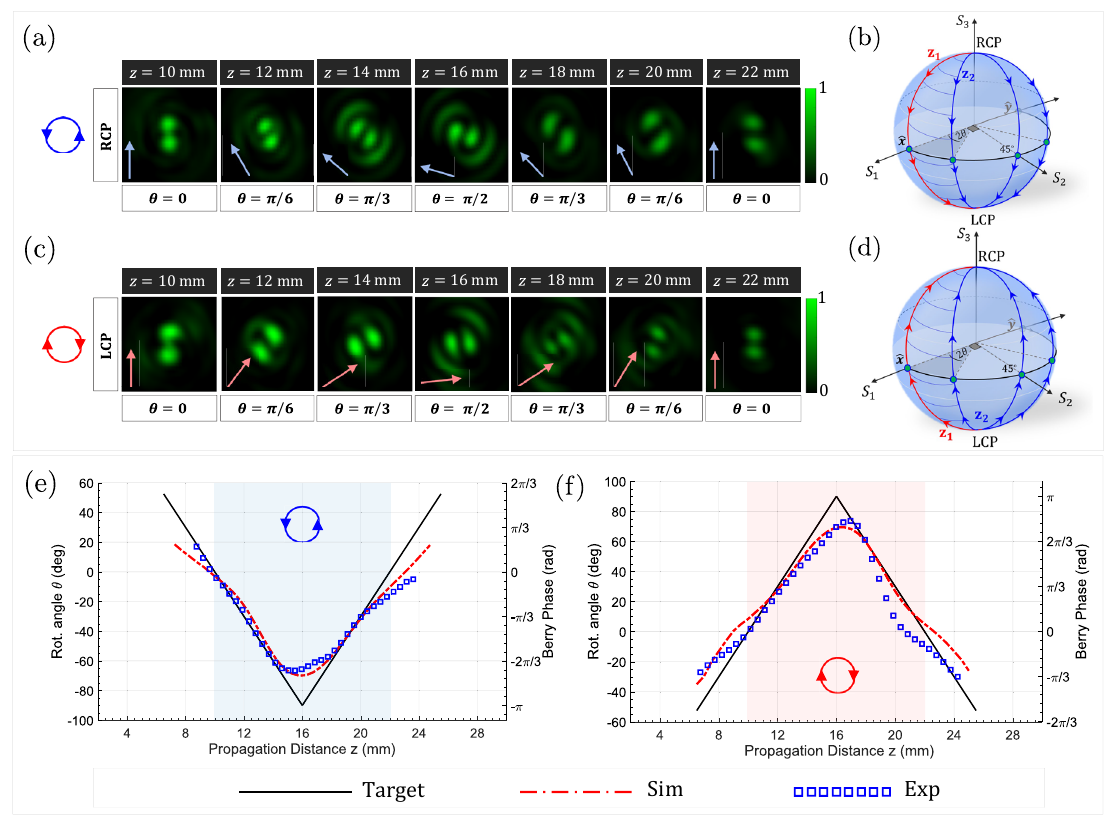
Figure 5: Direct measurement of spatially evolving Berry phase. (a and c) Measured transverse intensity profile of the metasurface in response to RCP (a) and LCP (c) input light. At each z -plane, the change in angular orientation of the petal structure suggests an additional Pancharatnam–Berry phase factor acquired by 𝜓 𝓁 =− 1 , equal to ( − 2 𝜎𝜃 ) where 𝜎 = ± 1 for RCP and LCP input light and 𝜃 is the fast axis orientation of HWP-1. The petals reverse their sense of rotation, consistent with changing 𝜃 . (b and d) The evolution in the polarization of 𝜓 𝓁 =− 1 (blue trajectory) and 𝜓 𝓁 = 1 (red trajectory) are shown on the Poincaré sphere for RCP (b) and LCP light (d). (e) Measured and simulated orientation of the rotating petal structures in (a) as a function of the propagation distance, compared to the designed HWP response. The response is spin-dependent; input LCP light exhibits opposite behavior at the output as shown in (f). In both cases, the magnitude of the accumulated Berry phase is evaluated as twice the angular orientation of the petal structure (as well as twice the fast axis orientation of HWP-1, 𝜃